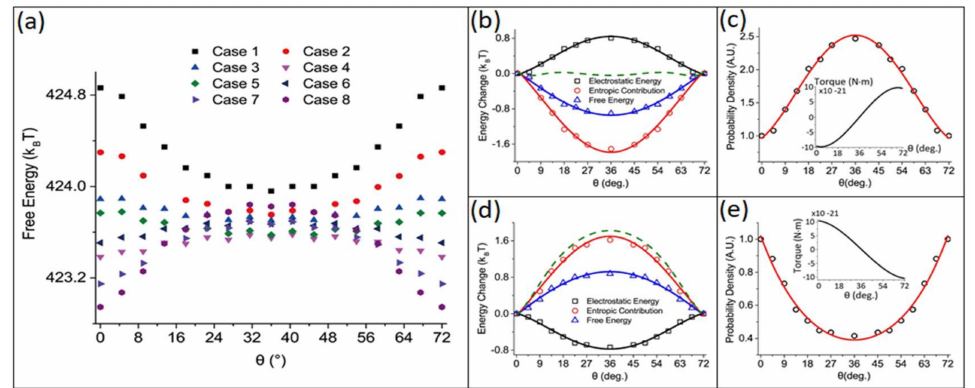
Figure 4. Energy change between two relative pentagon nanostructures as a function of the rotation angle, θ . ( a ) Dependence of the free energy on θ for the eight di ff erent cases shown in Figure 3a. In ( b , c ), the calculated results of the energy change and probability density as a function of the rotation angle in Case 1 are shown, whereas in ( d , e ), the corresponding values for Case 8 are